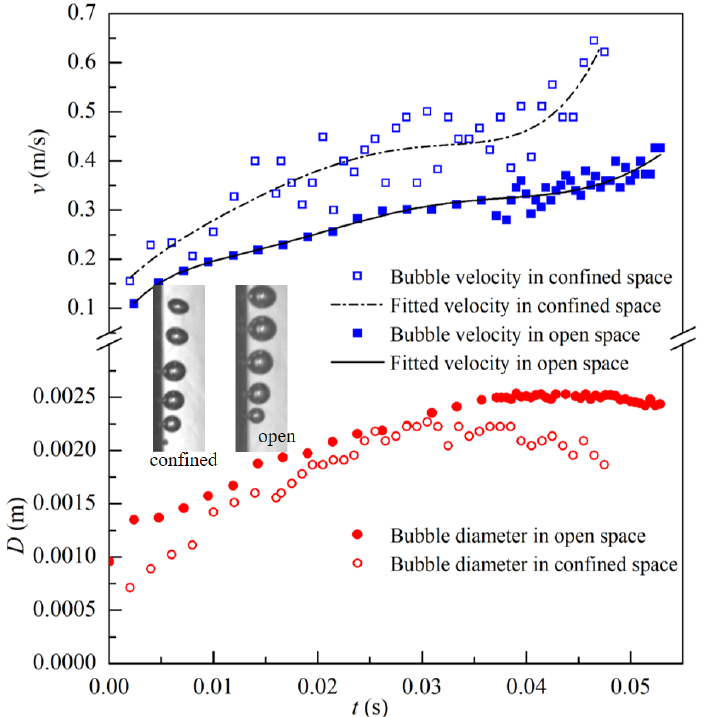
Figure 10. Comparison of bubble separation velocity and buoyancy velocity between confined and open space.